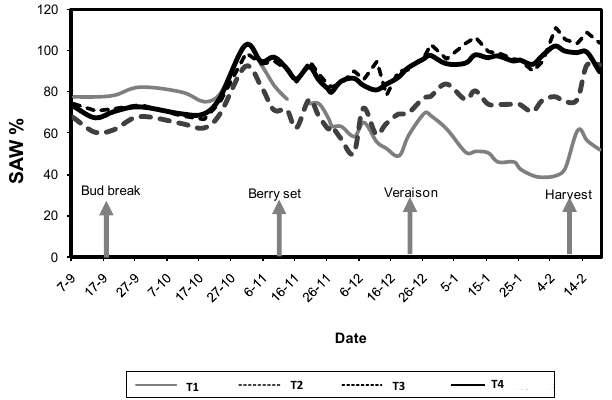
Figure 1. Typical variation of soil available water (SAW%), during the 2007/08 season. Arrows indicate different phenological stages. Table 2. Average soil available water (SAW%) in each experimental year. Irrigation Treatment